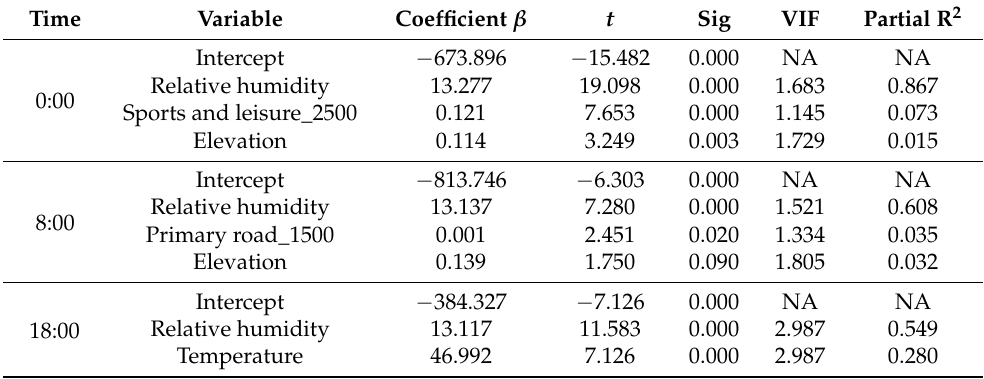
Table 4. The LUR models at different times during a winter working day.